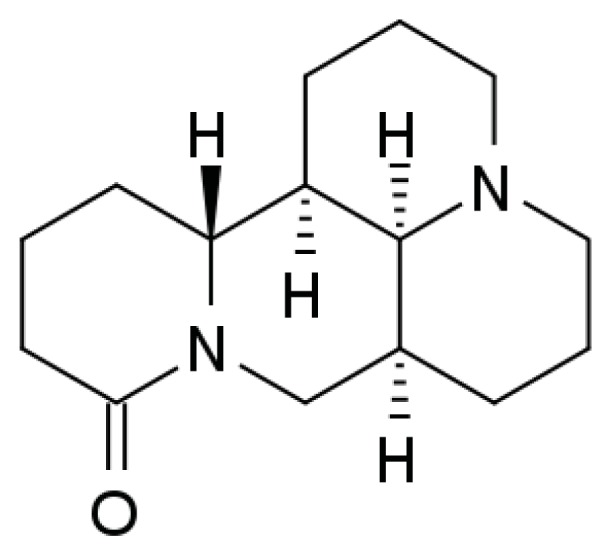
The structure of Matrine.